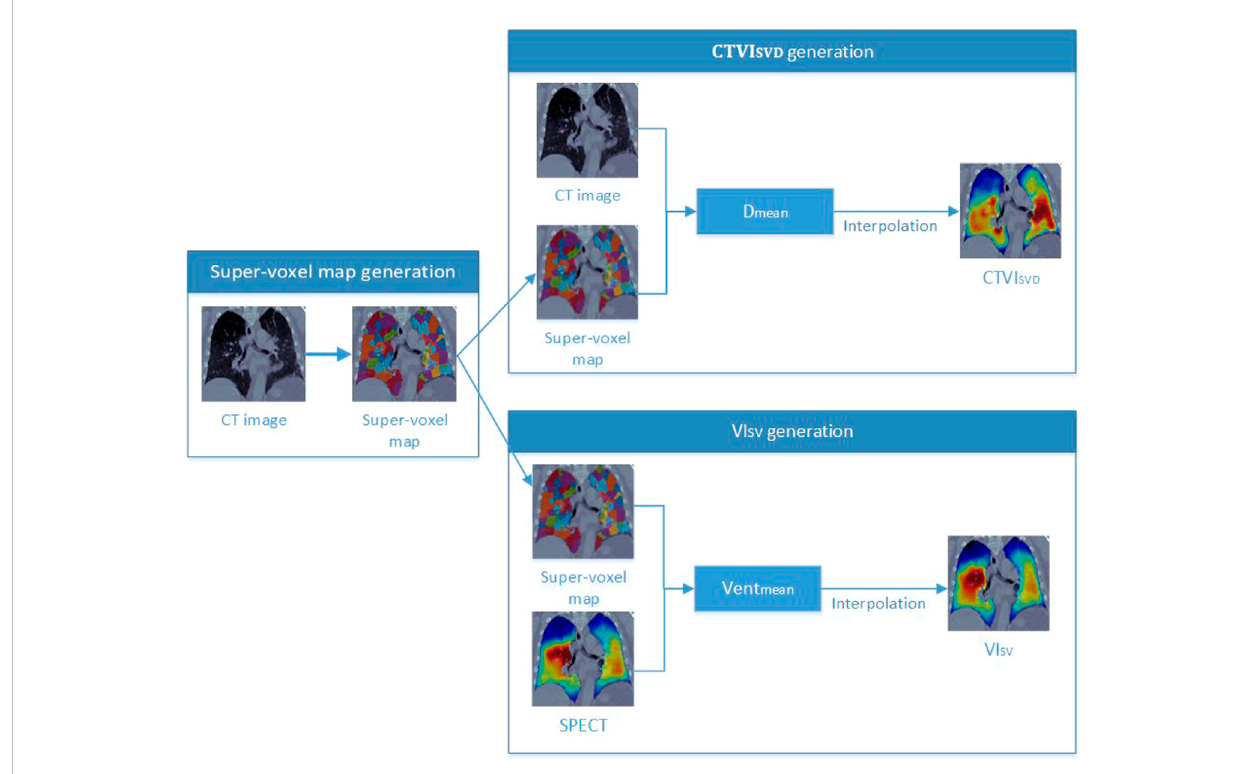
FIGURE 2 The work fl ow of the generations of the CTVI SVD and VI SV